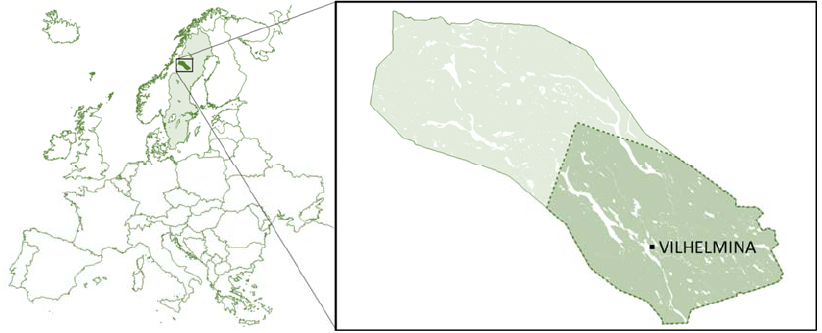
Figure 1. The location of Vilhelmina municipality (Sweden) and our focus study area within the municipality.